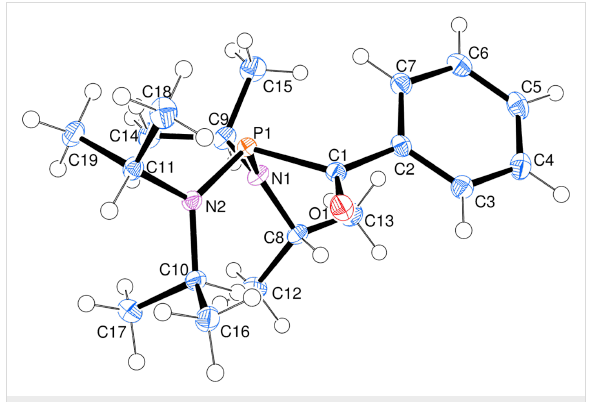
Figure 2: ORTEP [52] drawing of 9 . Selected distances (Å) and angles (°): P–N1 1.687(1), P–N2 1.679(1), P–C1 1.879(1), C1–O 1.221(1), C1–C2 1.495(1), C1–P–N1 99.90(5), C1–P–N2 100.59(5), P–C1–O 120.23(8), P–C1–C2 119.78(8), C2–C1–O